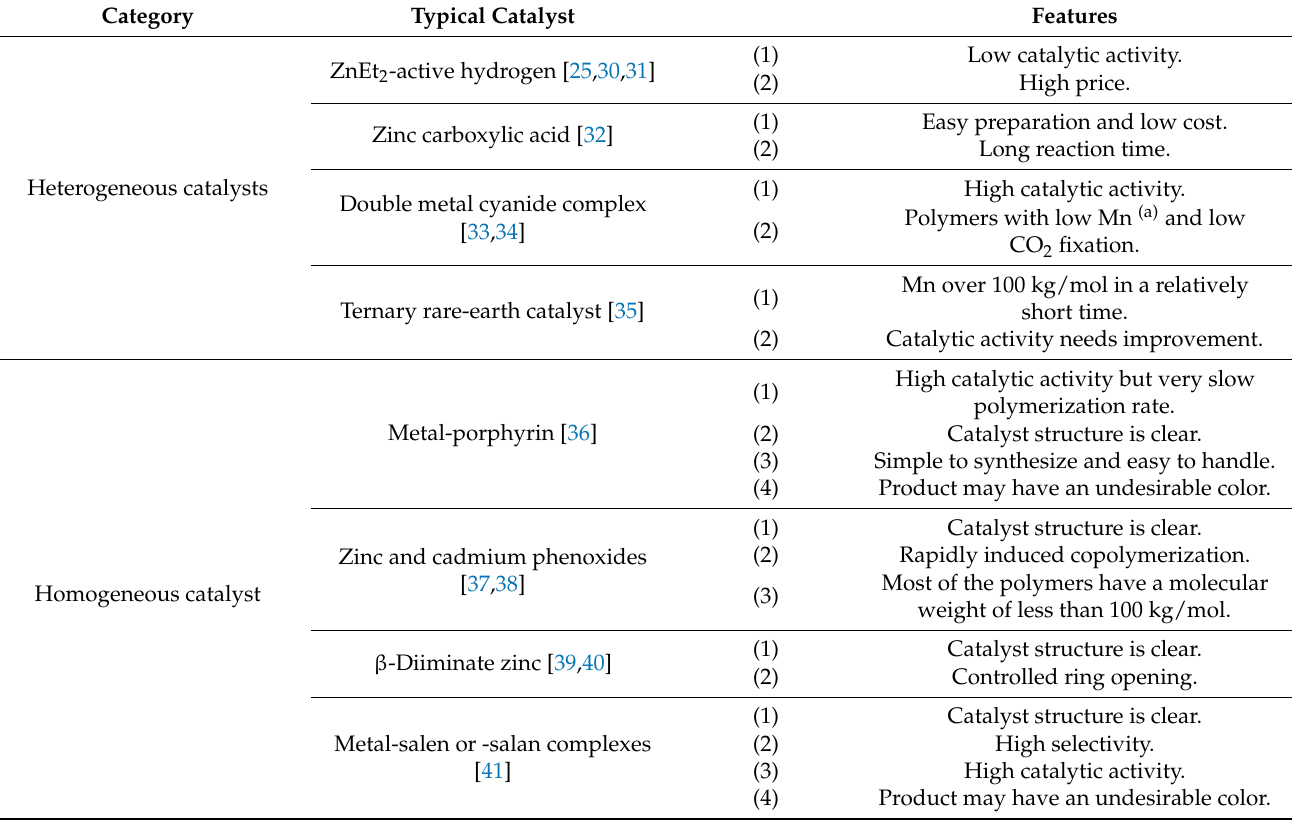
Table 2. Catalysts for the copolymerization of CO 2 and epoxides [28,29].